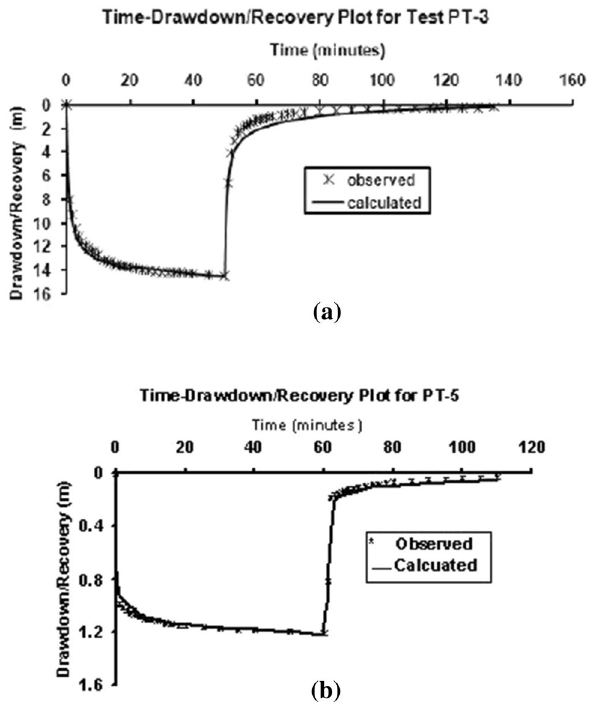
Fig. 4 Interpreted time-drawdown/recovery plot by numerical meth- ods for test in pediplain with moderate weathering (PPM) geomor- phologic units